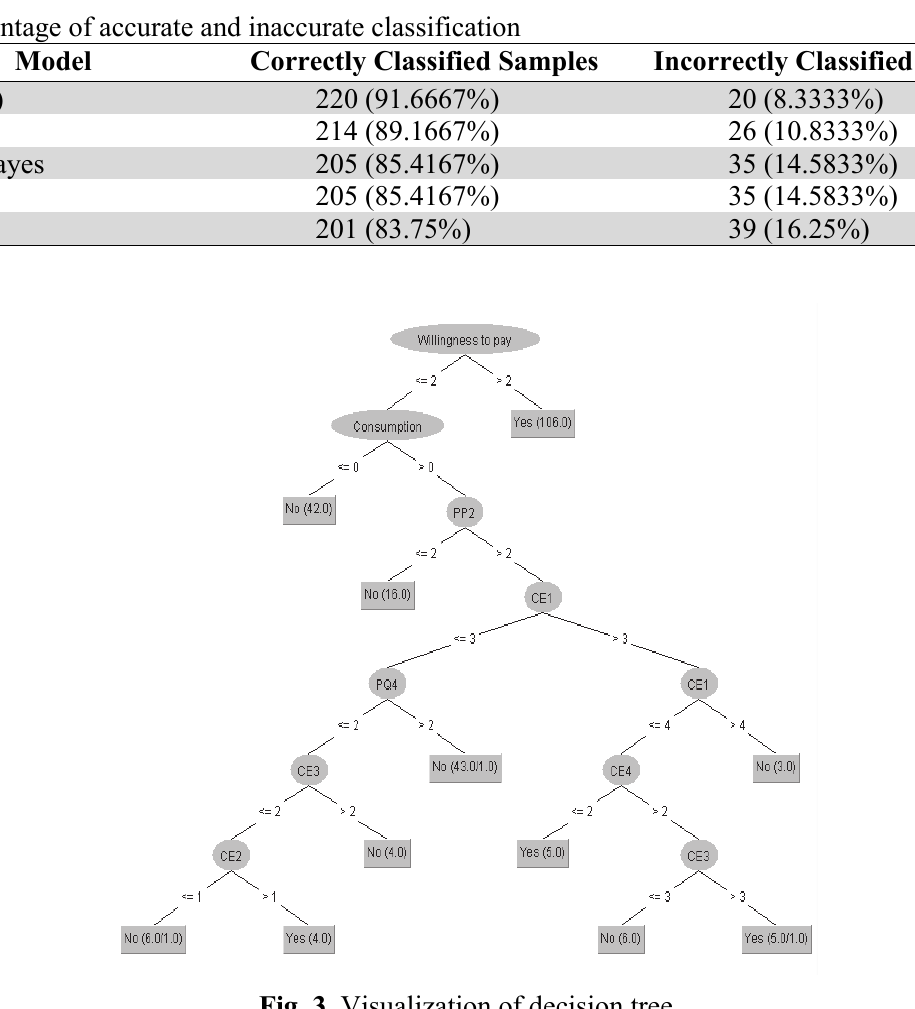
Fig. 3. Visualization of decision